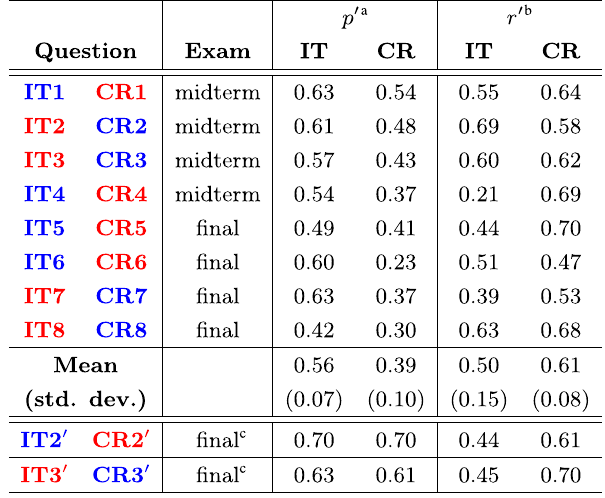
TABLE I. Summary of question measures and their placement in midterm and final